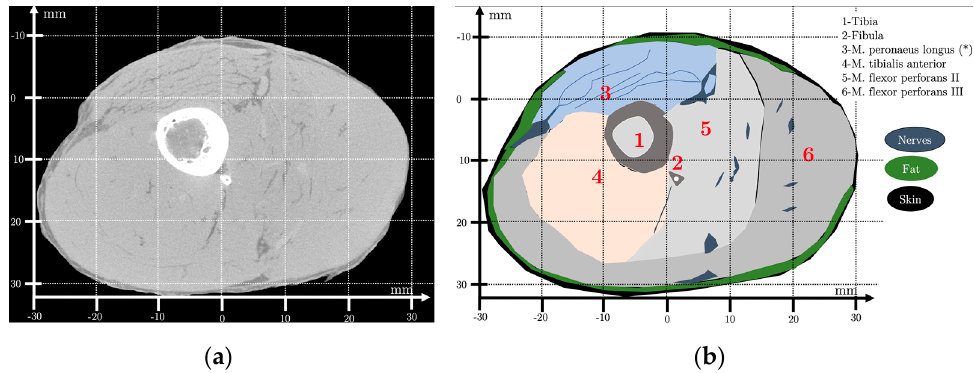
Figure 3. ( a ) X-ray computed tomography ( μ CT) of an ex vivo chicken drumstick in proximal 25 mm to the superior tibio-fibular joint. Size: 1840 × 1456 pixels 2 ; resolution: 50 μ m. ( b ) Studied region of interest and schematic topographic anatomy. Abbreviations: M. = musculus; (*) muscles fixed on the kneecap with linear long fibers.